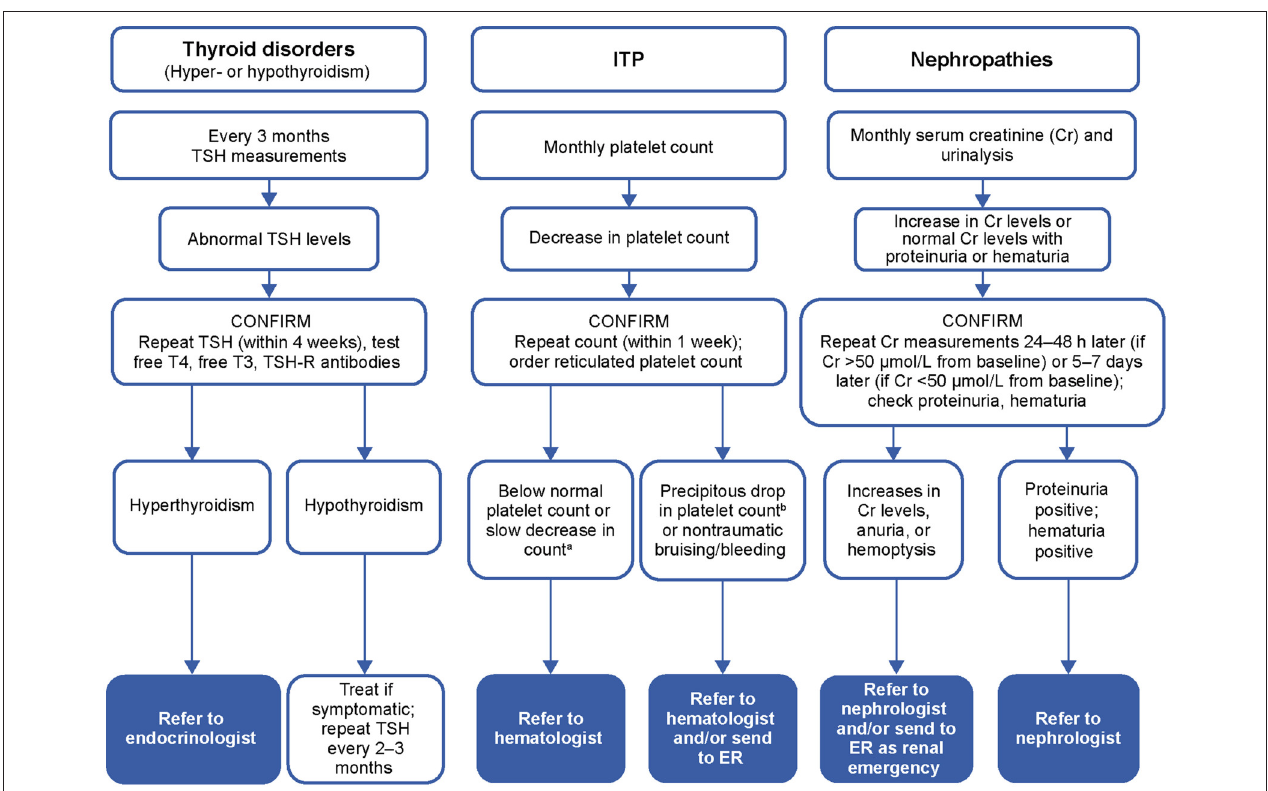
FIGURE 4 | Overview of the laboratory testing plan for autoimmune disorder risk monitoring. a Approximately 10% decrease in 3 successive measurements or > 30% decrease from previous month or reticulated platelet count is above normal; b Platelet count < 50 × 10 9 /L. T3, triiodothyronine; T4, thyroxine; TSH, thyroid-stimulating hormone; TSH-R, thyroid-stimulating hormone-receptor; ER, emergency